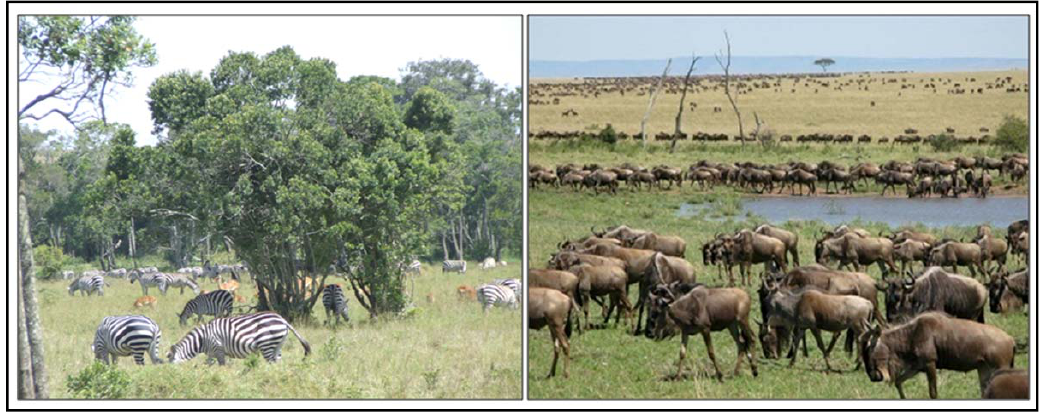
Figure 5. High concentrations of different wildlife species are common in the Masai Mara Ecosystem.